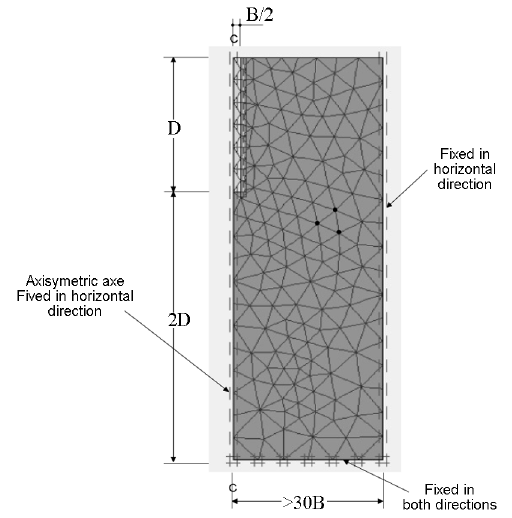
Fig. 3. Geometry and boundary conditions of the used numeri- cal model